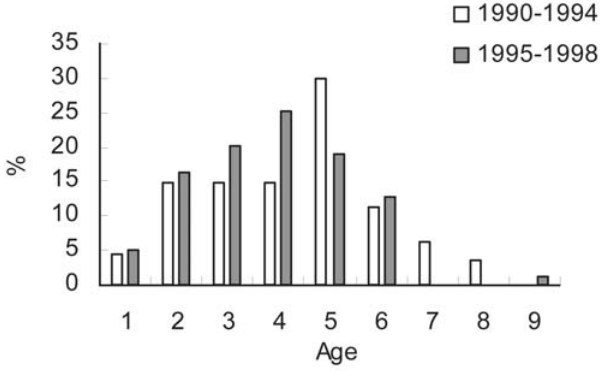
Fig. 4 . Age structure of L. acutidens compared by study pe- riod.